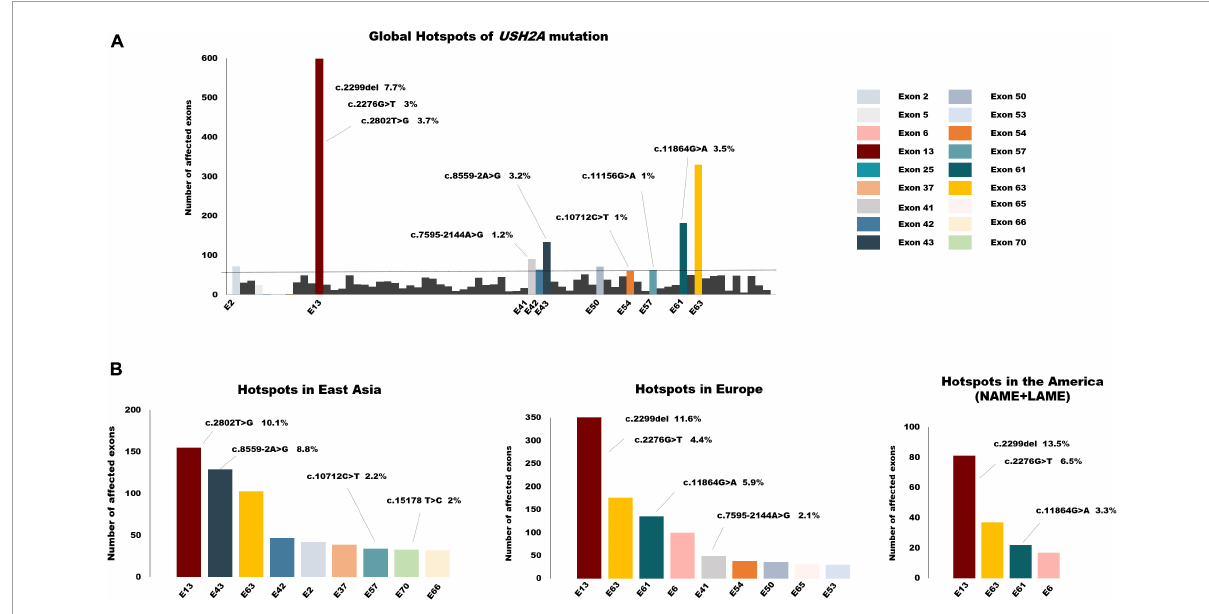
FIGURE5 The global spectrum of USH2A variants. (A) Global hotspots of USH2A mutation. Exons colored are the top 10 hotspot mutant exons which accounted for more than half of all the alleles in total. (B) Hotspot exons and mutations of USH2A in different continents. Mutant alleles with a frequency of > 1% were listed above the relevant